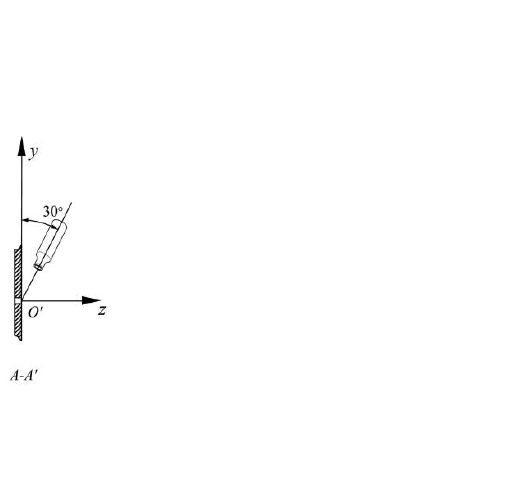
7 of 18 Figure 5. Schematic diagram of the air cleaning process: ( a ) before removing the seed; ( b ) after re- moving the seed. The cleaning mechanism is composed of a nozzle and a connecting pipe, which is installed at the position of the cleaning mechanism that is determined by the above theo- retical analysis. The nozzle is oriented perpendicular to the auxiliary seed suction device and it points to the suction hole’s position. Since the internal space of the seed metering device is small and the air pressure requirement of the cleaning mechanism is small, re- ferring to the relevant literature [24], the inlet radius is 5 mm, the wall thickness is 1 mm, the length of the connecting pipe is 20 mm, and the length of the nozzle is 10 mm. The existing research has found that, when the constriction angle of the conical nozzle is be- tween 10° and 30°, the clustering is better [25]; therefore this paper has selected a con- striction angle of 15° and an exit radius of 2.5 mm. In order to better show the installation position of the cleaning mechanism, the upper intersection of the circle where the suction hole is located and the vertical line passing through the axis O position was set as the